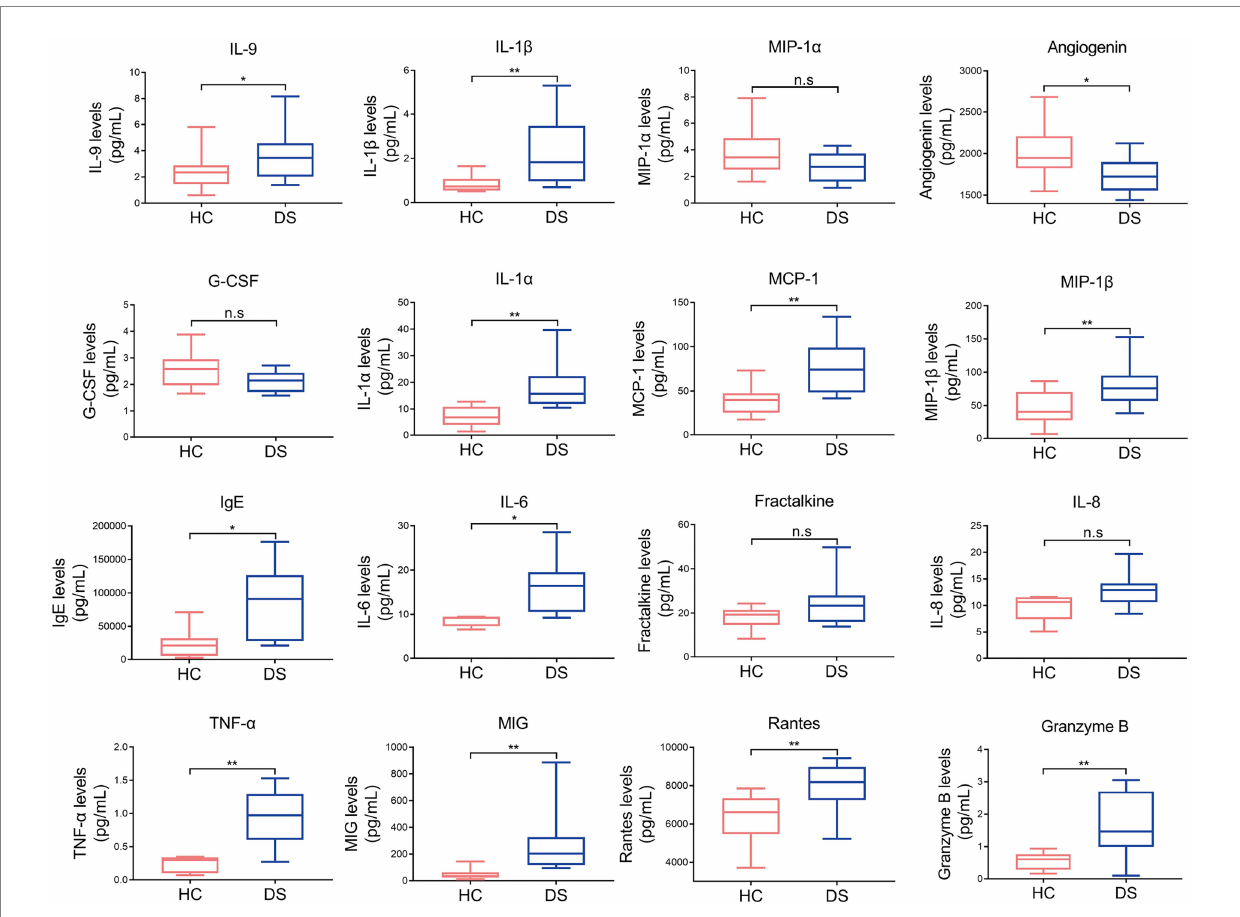
FIGURE 1 Pro-inflammatory and anti-inflammatory cytokines in individuals with DS and non-DS volunteers (HC). Serum levels of IL-9, IL-1 β , MIP-1 α , angiogenin, G-CSF, IL-1 α , MCP-1, MIP-1 β , IgE, IL-6, fractalkine, IL-8, TNF- α , MIG, rantes, and granzyme B were analyzed by multiparameter flow cytometry. * p < 0.05 and ** p < 0.01 when comparing DS with the non-DS